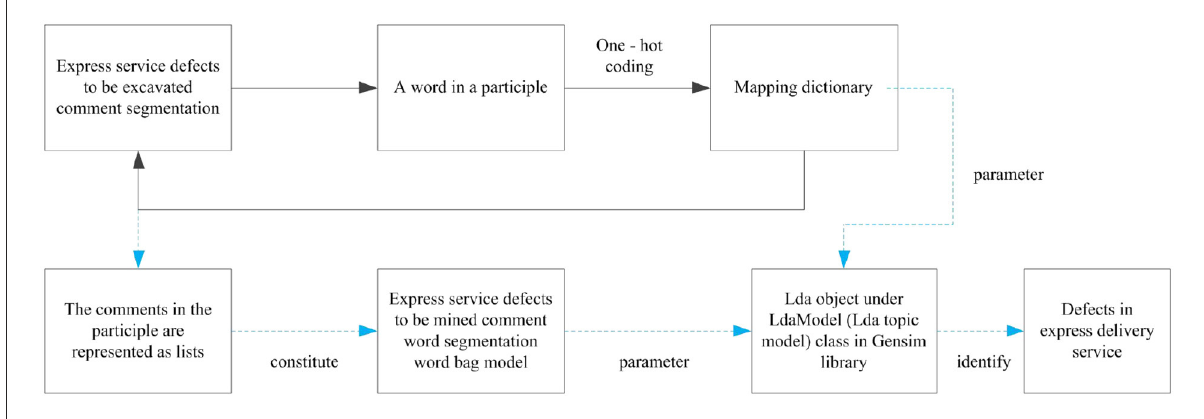
FIGURE5 Process for identifying delivery service